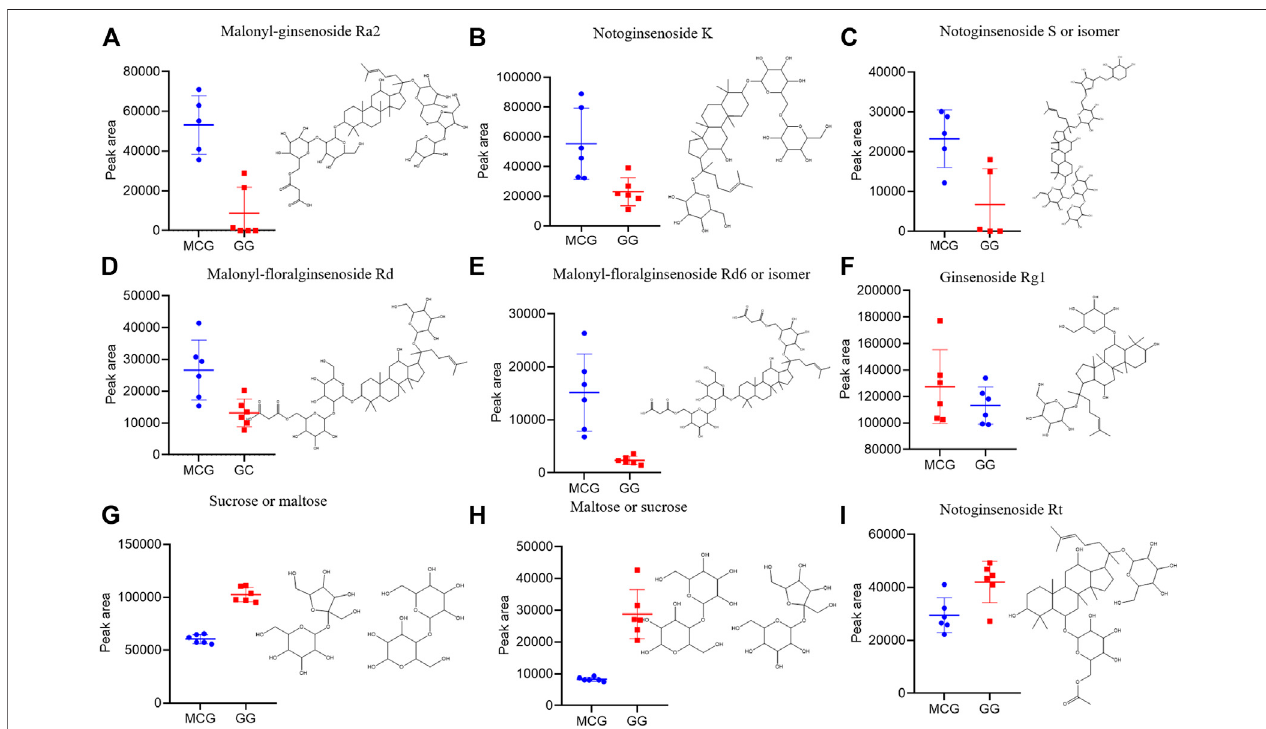
FIGURE 2 | Box charts illustrating the distribution difference of the nine marker compounds among MCG and GG. (A – F) can be the characteristic components of MCG. (G – I) can be the characteristic components of GG.